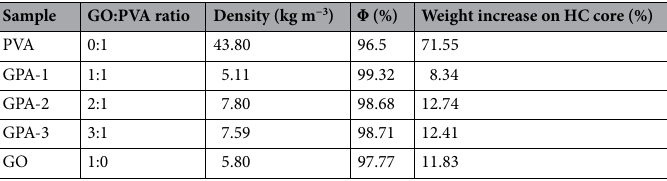
Table 1. Physical properties of all samples.